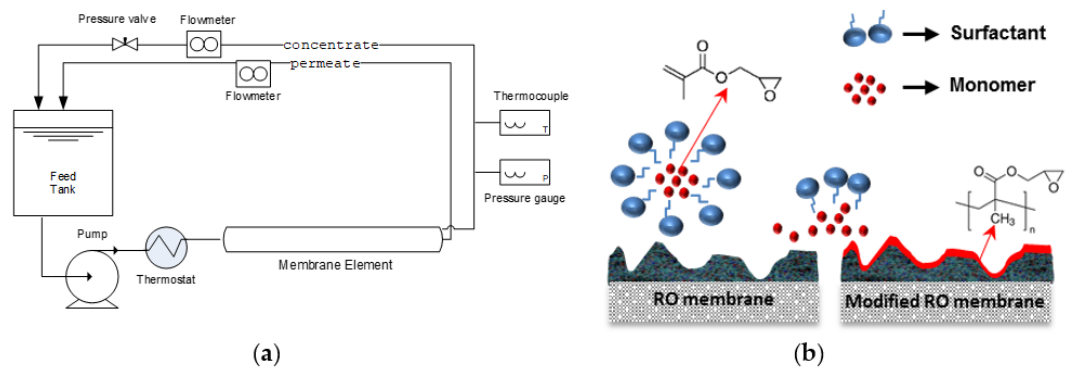
Figure 1. ( a ) Schematic representation of the set-ups for modification and the testing element. ( b ) Schematic illustration of formation mechanism of the grafted